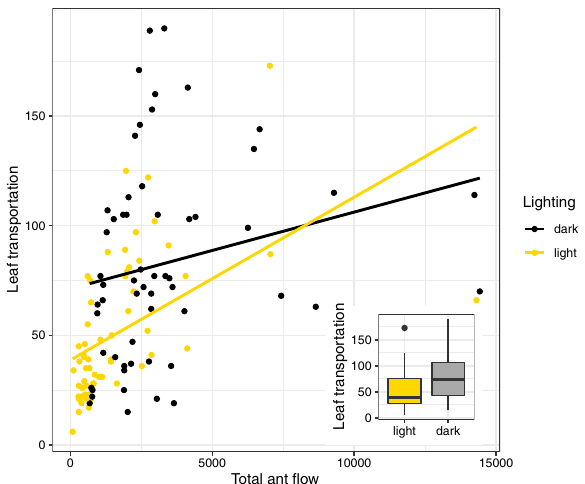
Figure 4. Leaf transportation as a function of total ant flow for the two lighting conditions. Note that foraging efficiency, given by the slope of the curves, varies between day and night (lm: F (1, 116) = 18.926, p < 0.001). Foraging during day, although less frequent, is more efficient. Inserted boxplot indicates the amount of leaf transported during day and night.